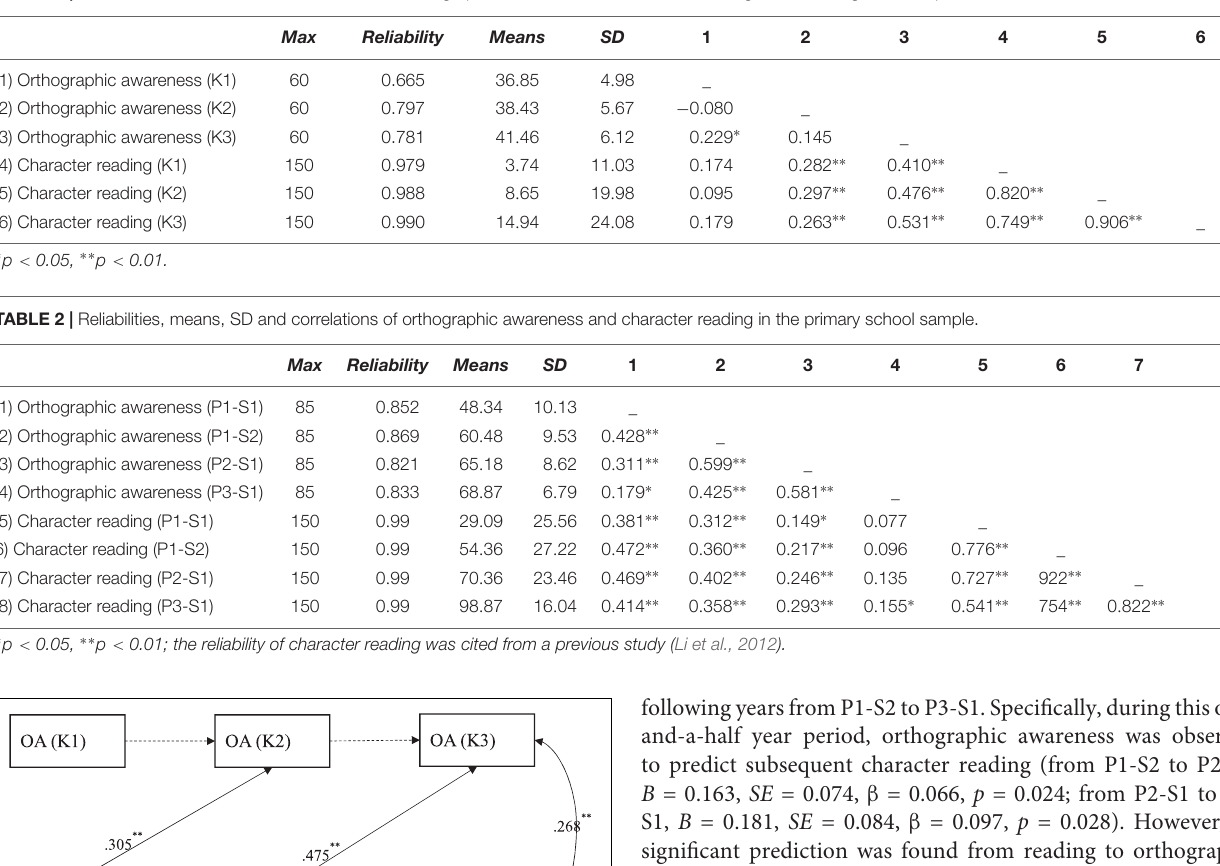
SE = 0.032, β = 0.475, p < 0.01). However,